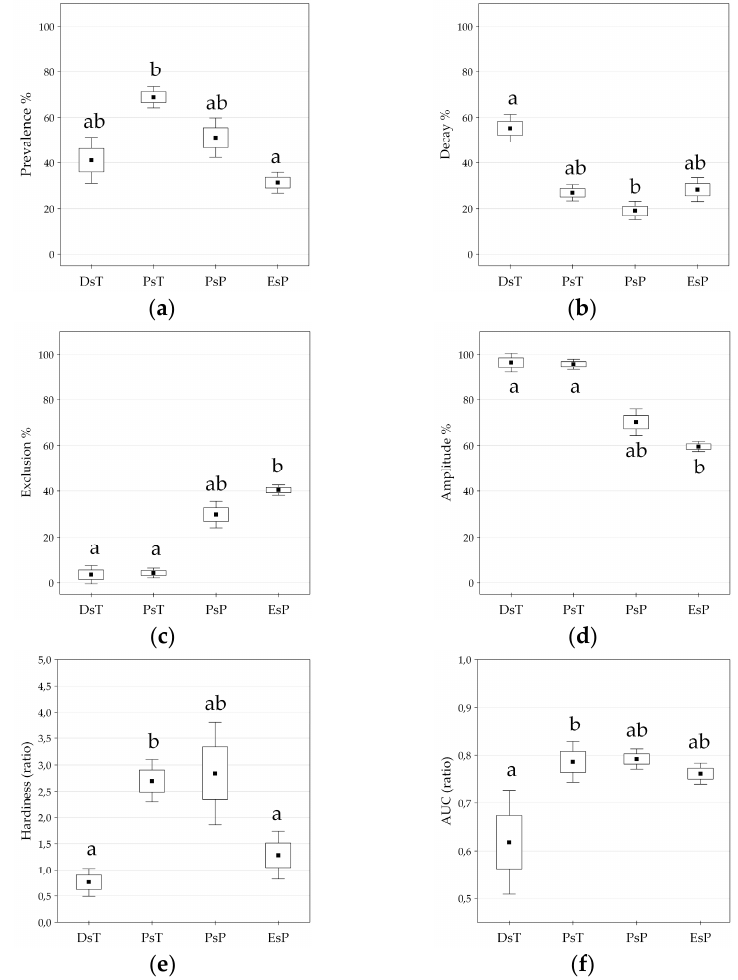
Figure 6. ( a – f ) Differences in temperature and precipitation-related functional units classified by the six response function measures of appropriate sets of variables (see also Figure 5). ( a ) Prevalence function; ( b ) Decay function; ( c ) Exclusion function; ( d ) Amplitude; ( e ) Hardiness; ( f ) Area Under the Curve (AUC value). DsT = Decay-specific Temperature group; PsT = Prevalence-specific Temperature group; PsP = Prevalence-specific Precipitation group; EsP = Exclusion-specific Precipitation group. Kruskal-Wallis test, Mean ± SE in the boxplots, significant differences are indicated by lowercase letters, p < 0.05